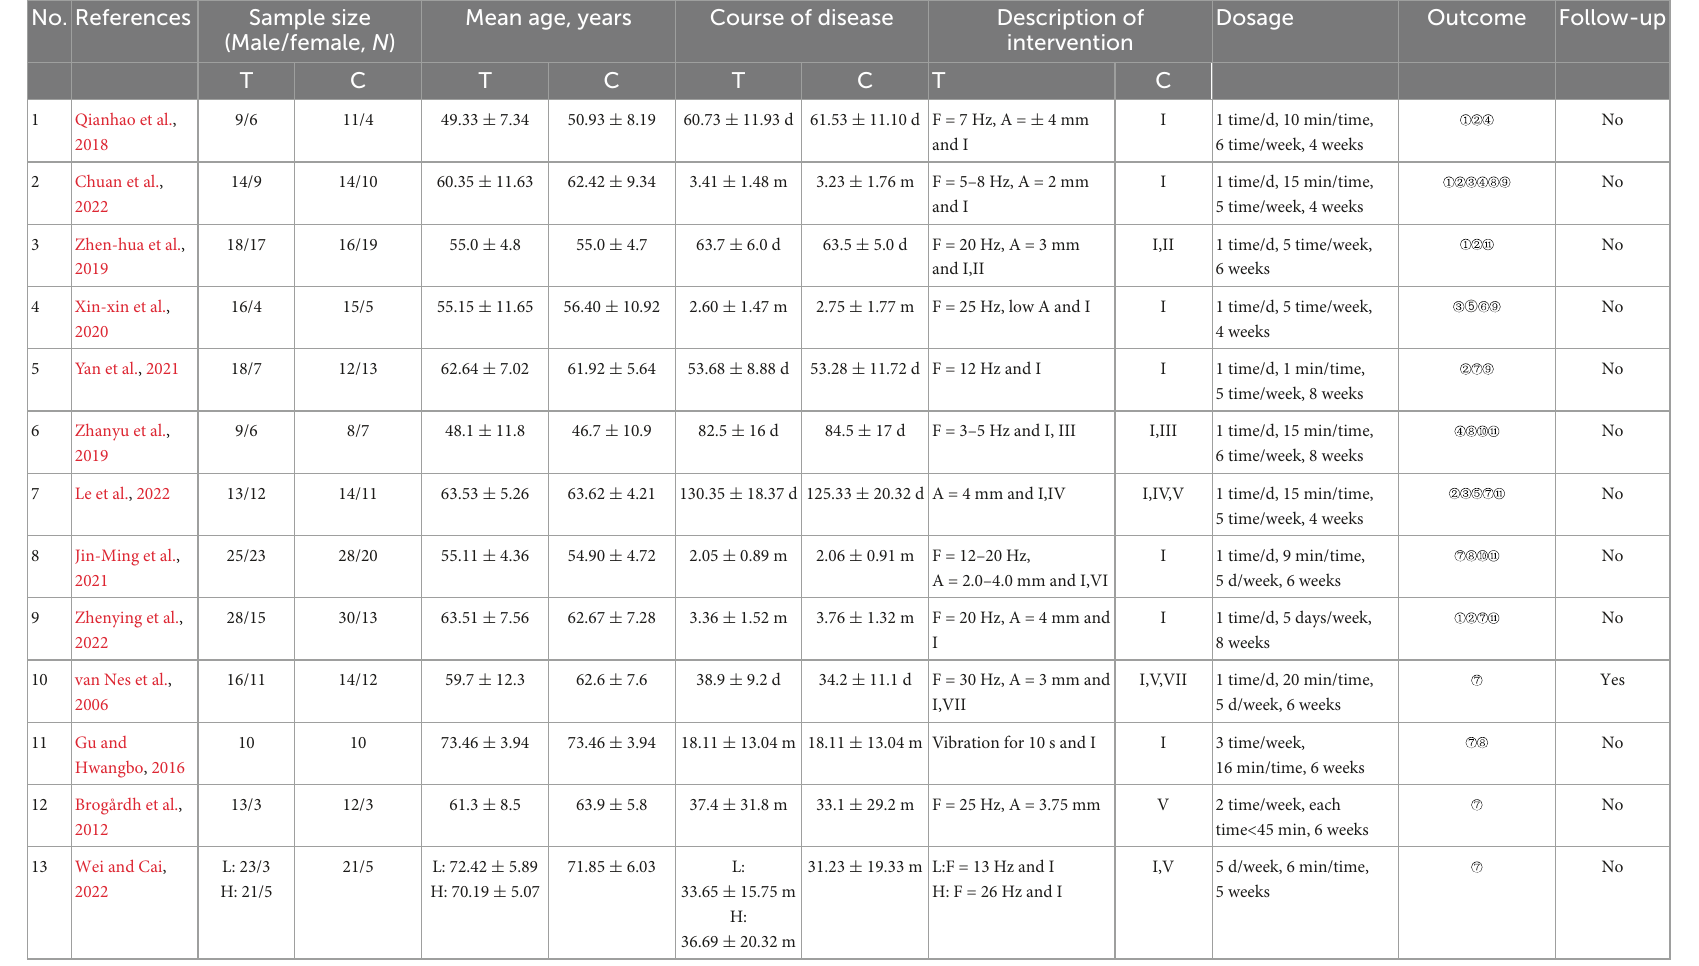
TABLE 1 The details of research